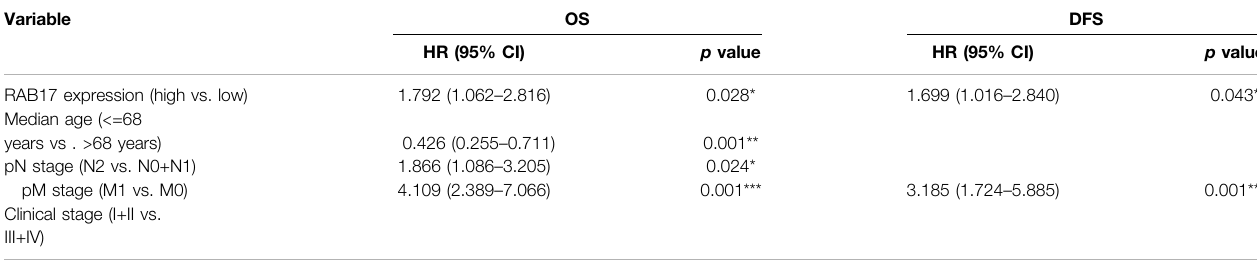
TABLE 1 | Multivariate Cox regression analysis of RAB17 mRNA expression in CRC patients from TCGA. Variable